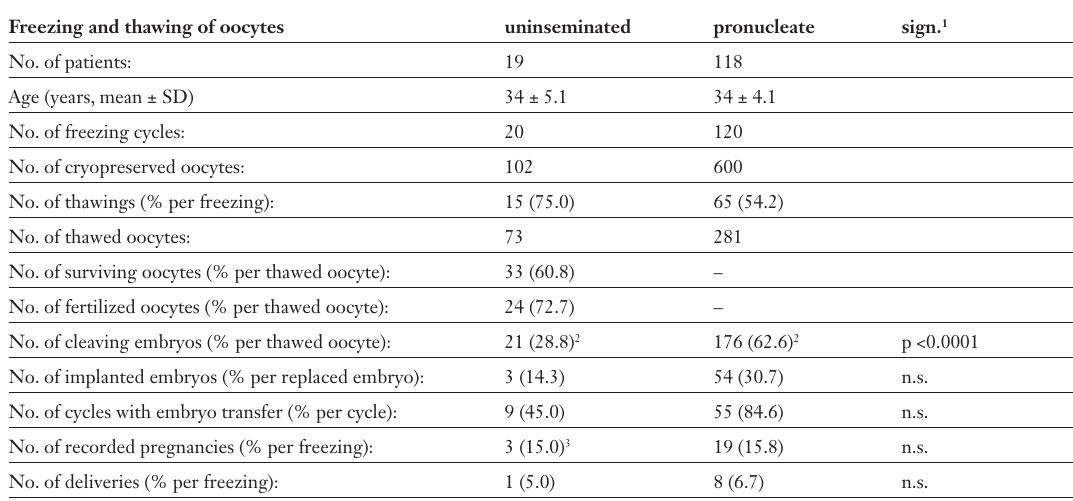
(figure 1). Six days after embryo transfer the luteal phase was supported with one single injection of 5000 international units of HCG (Pregnyl). An intact intrauterine singleton pregnancy was con- firmed by serial measurements of human chori- onic gonadotropin serum levels and vaginal ultra- sound. The pregnancy evolved without complica-